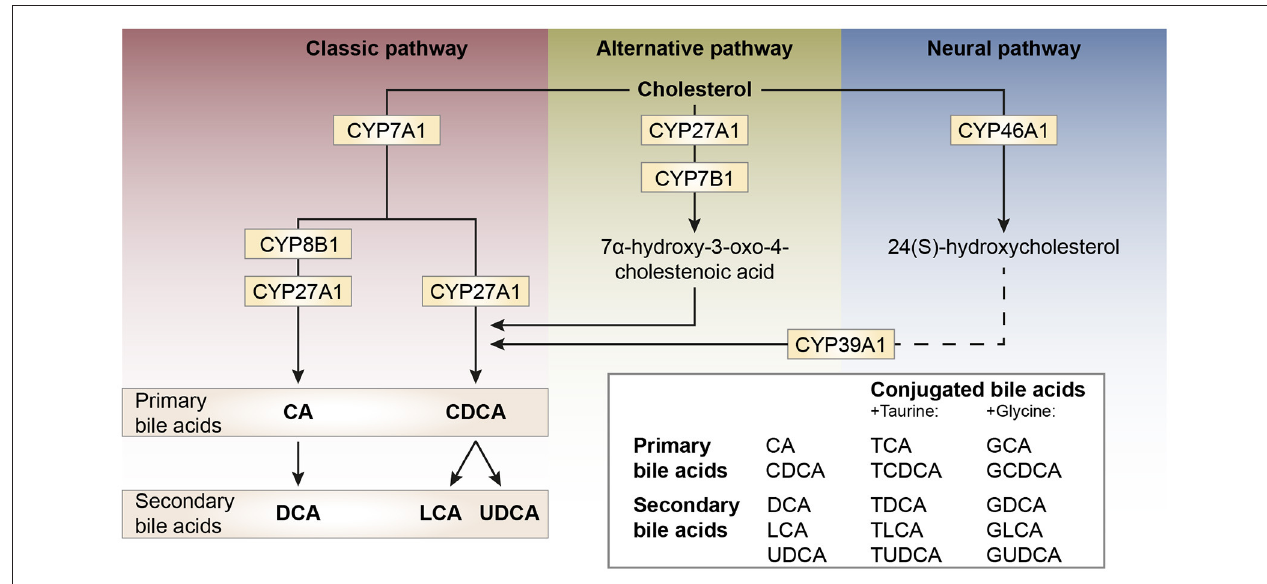
FIGURE 1 | Schematic representation of bile acid synthesis pathways in humans. Bile acid synthesis from cholesterol occurs via different pathways. The classic pathway occurs in the liver and is responsible for the majority of bile acid synthesis. This pathway is initiated by the enzyme cholesterol 7 α -hydroxylase (encoded by CYP7A1) and results in the formation of the primary bile acids cholic acid (CA) and chenodeoxycholic acid (CDCA). Key enzymes for the formation of CA or CDCA are sterol 12 α -hydroxylase (CYP8B1) and sterol-27 hydroxylase (CYP27A1), respectively. In rodents, the primary bile acids formed are CA and muricholic acid (MCA). The primary bile acids are conjugated to the amino acids glycine (G, mainly in humans) or taurine (T, mainly in rodents) forming conjugated bile acids and bile salts. The formation of secondary bile acids occurs in the intestine under the control of gut flora and when returned to the liver these secondary bile acids can also be conjugated to glycine and taurine. The alternative pathway of bile acid synthesis also occurs in other tissues besides the liver. This pathway is initiated by CYP27A1 and also involves CYP7B1. After several metabolic steps CDCA is formed. The last pathway occurs in the brain and is believed to be important for neuronal cholesterol clearance. Cholesterol is converted to 24(S)-hydroxycholesterol by CYP46A1 and subsequently exits the brain and enters the bloodstream (dotted line). In the liver, bile acid synthesis continues involving CYP39A1 resulting in CDCA after several